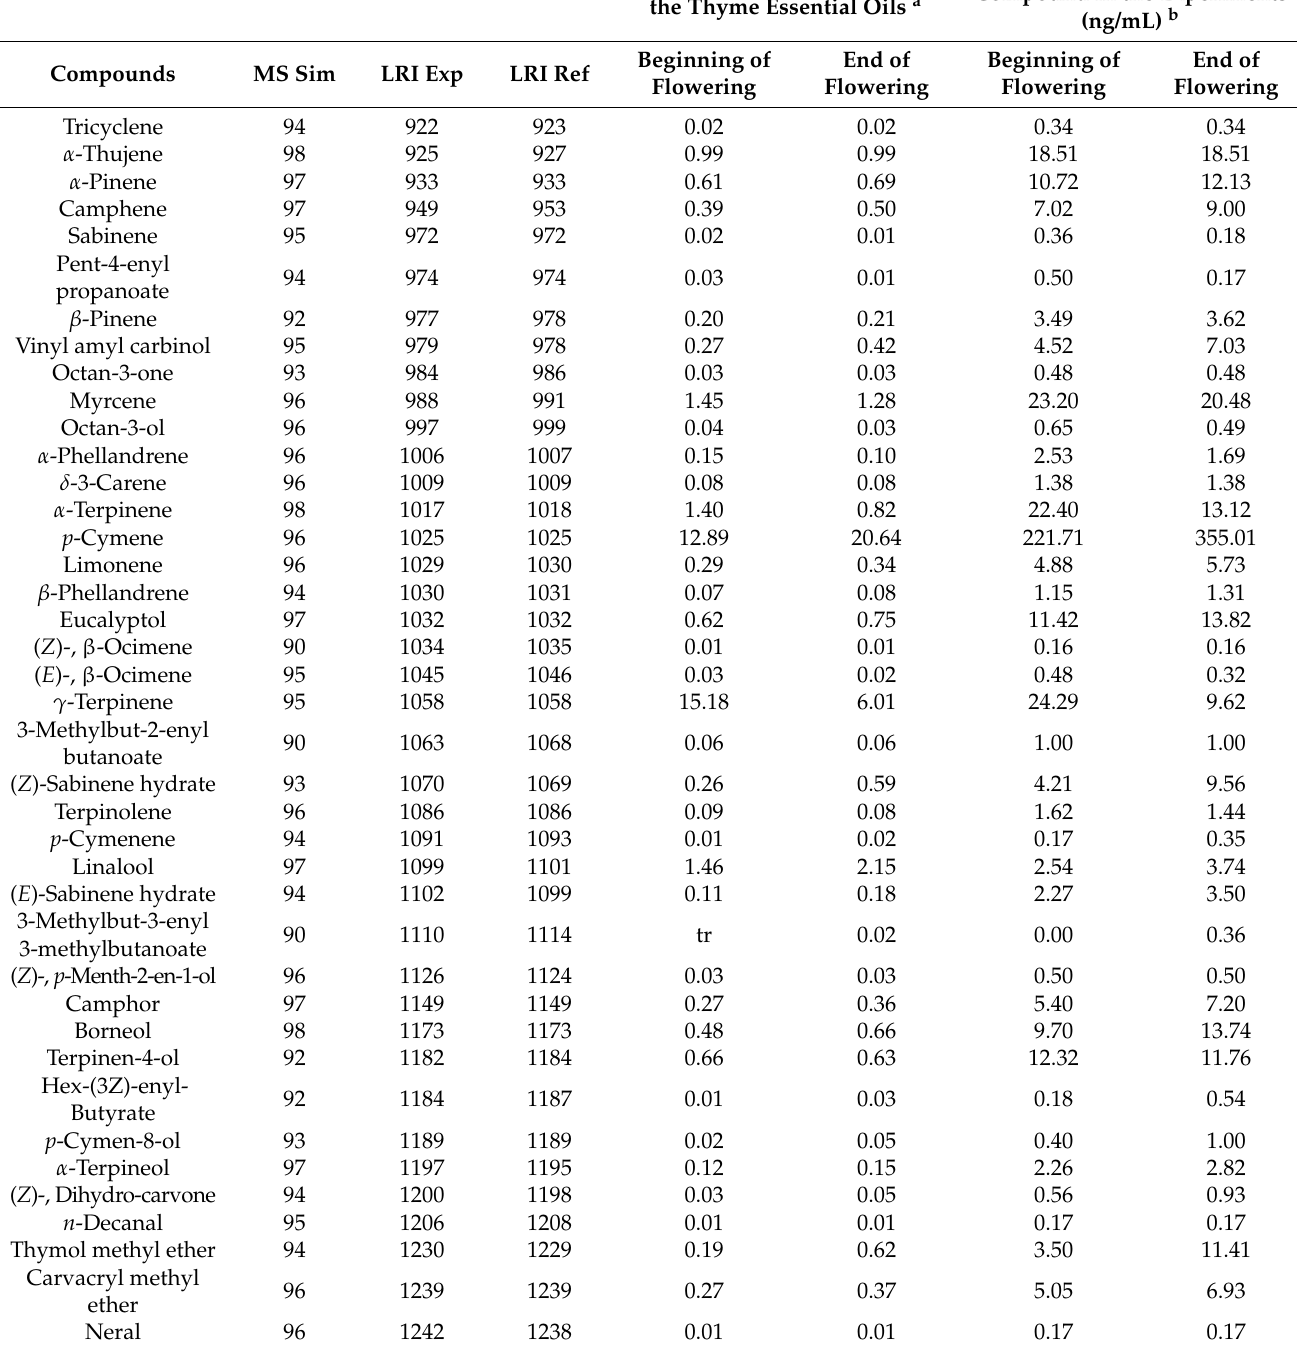
Relative Concentration of Percentage of Compound in Compound in the Experiments the Thyme Essential Oils a (ng/mL) b Beginning of End of Beginning of End of Flowering Flowering Flowering